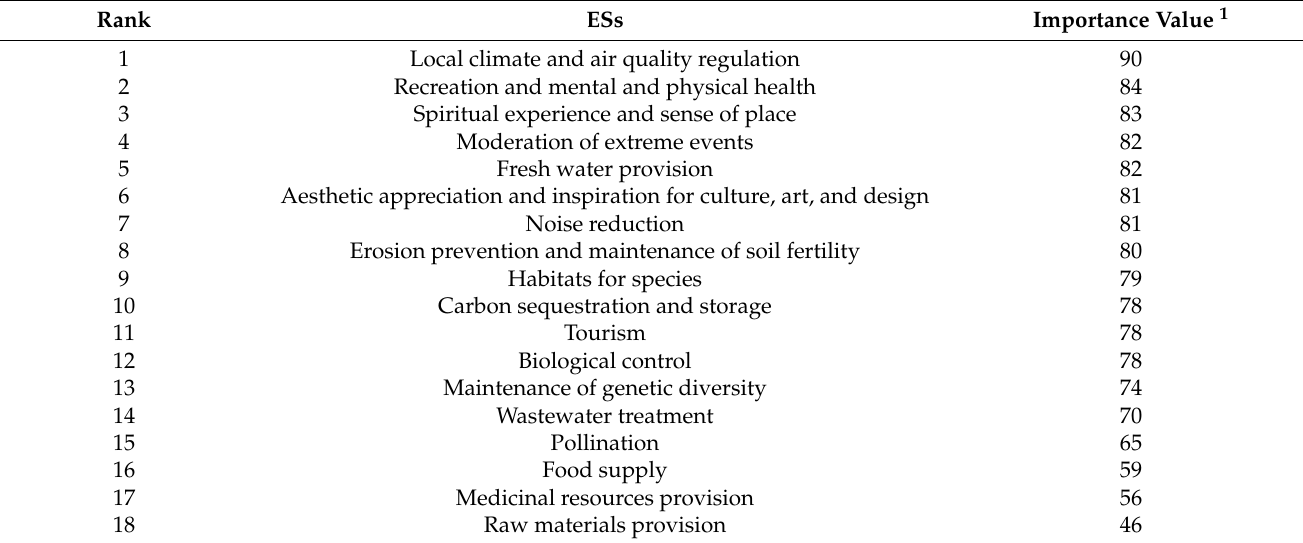
Table 2. Ranking the importance value of ESs in the first experts’ online